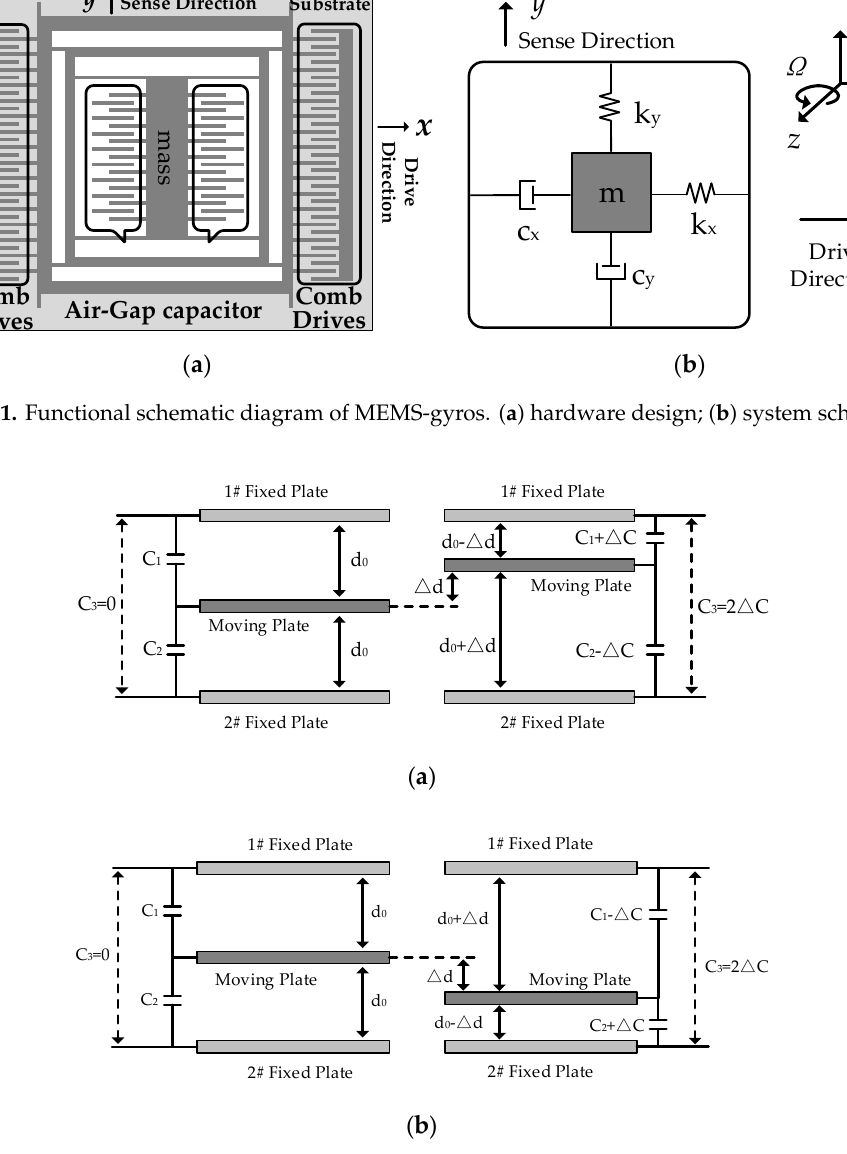
Figure 2. State diagram of the combs before and after rotation. ( a ) clockwise; ( b ) counter-clockwise. Based on plate capacitors’ definition, C 3 between 1# fixed plate and 2# fixed plate can be obtained: